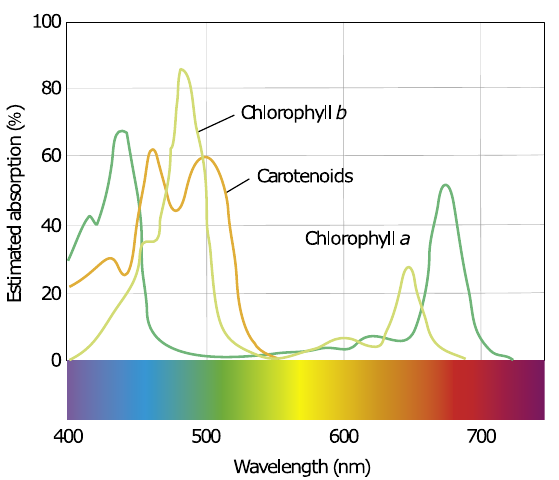
Figure 2. Absorption spectrum for chlorophylls and carotenoids (based on data from [37]). The photosynthetic efficiency (i.e., the fraction of light energy converted into chemical energy during photosynthesis) depends on the wavelength of light. The red light (600–700 nm) is the most efficient; the efficiency increases when coupled to an equal far-red light (700–800 nm). The violet-blue light, even if less efficient (efficiency = 0.65–0.75) [38],